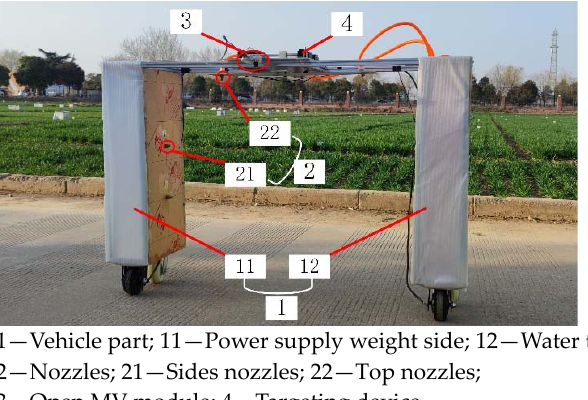
Figure 1. Machine